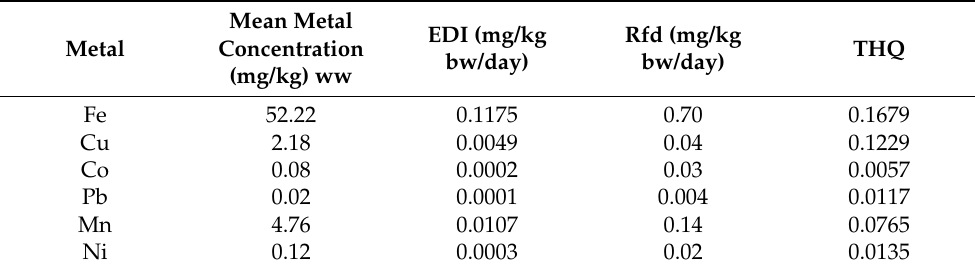
Table 7. Estimated oral reference doses, estimated daily intakes, and target hazard quotients from shellfish